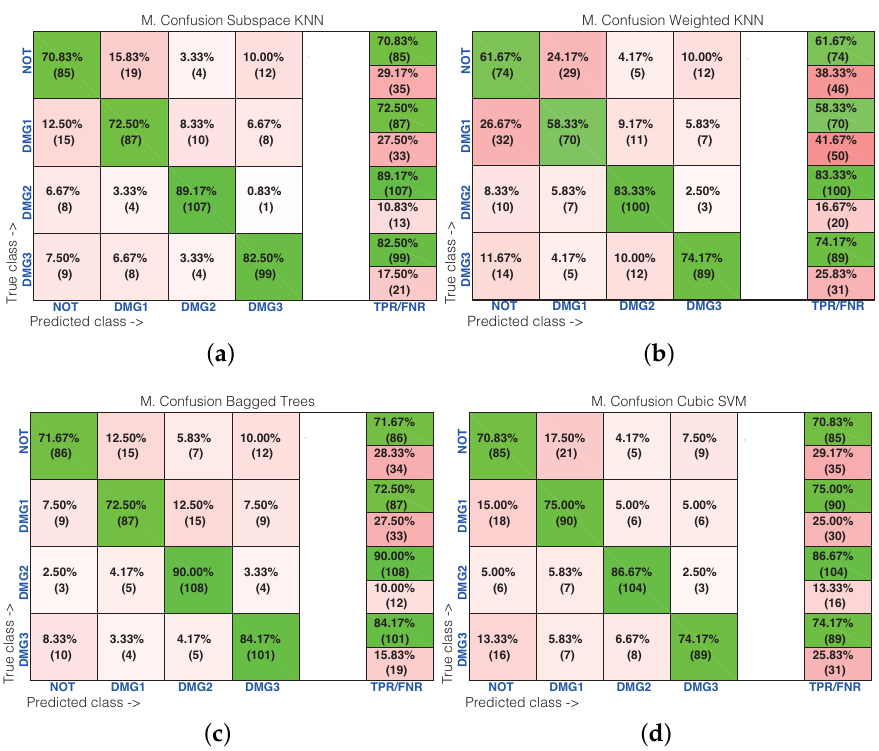
Figure 23. Confusion matrix machines with good behavior. ( a ) Subspace k -NN; ( b ) weighted k -NN; ( c ) bagged Trees; ( d ) cubic SVM.